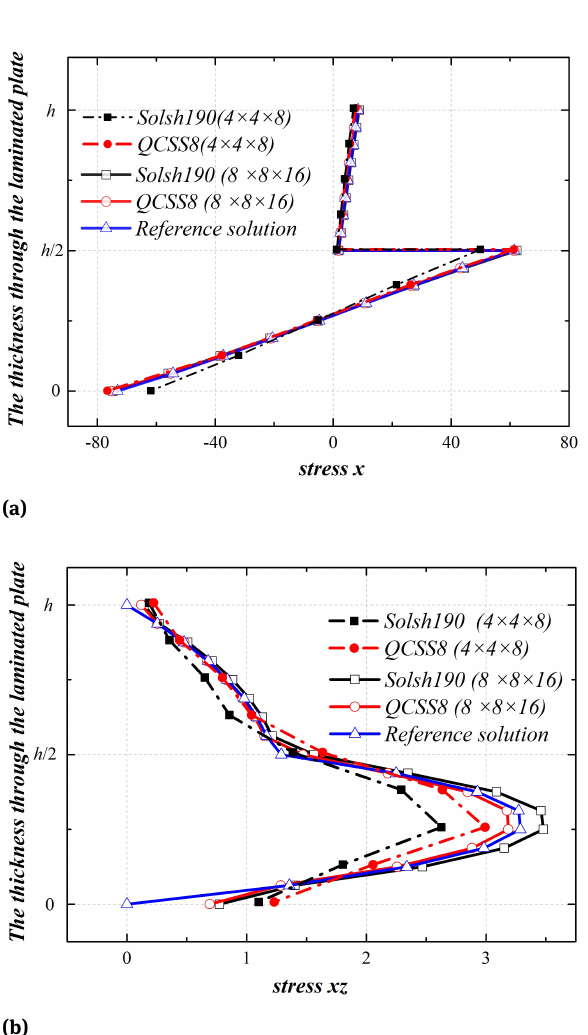
Figure 6: The distribution of stress σ x and stress τ xz through the thickness of the asymmetric cross-ply [0/90] plate subjected to the sinusoidally distributed load ( a / h = 10